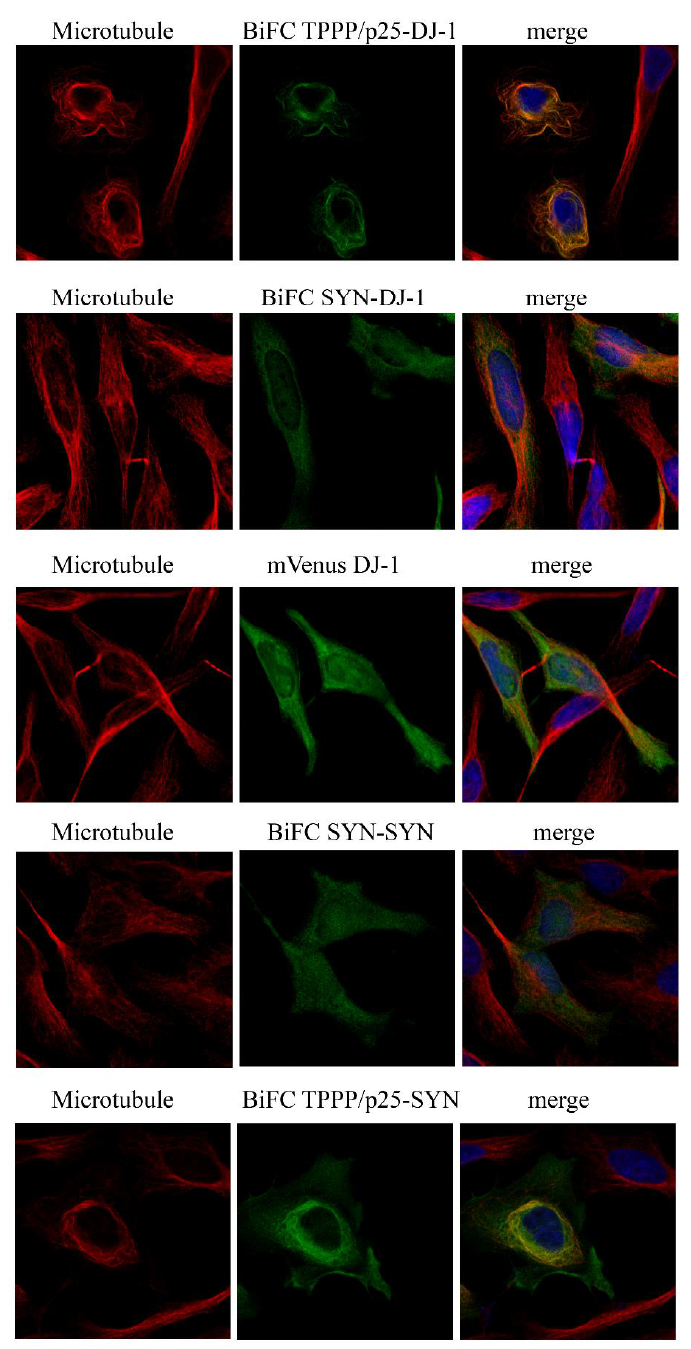
Figure 2. Hetero-association of DJ-1 with SYN or TPPP/p25 in living HeLa cells as visualized by BiFC technology (BiFC signal green). V C and V N fragments of Venus were conjugated to DJ-1 and TPPP/p25 (V N -DJ-1 and V C -TPPP/p25) or SYN (V N -SYN and V C -DJ-1), and their plasmids were co-transfected or mVenus-conjugated DJ-1 was transfected as the control. The associations of SYN with SYN or TPPP/p25 (V N -SYN and V C -TPPP/p25) visualized by BiFC technology are also shown. Alignment of the TPPP/p25-DJ-1 BiFC complex (green) on the microtubule network (red). All the details of the experiments are described in the Materials and Methods. Nuclei, blue (Hoescht 33342). Bar: 5 µ